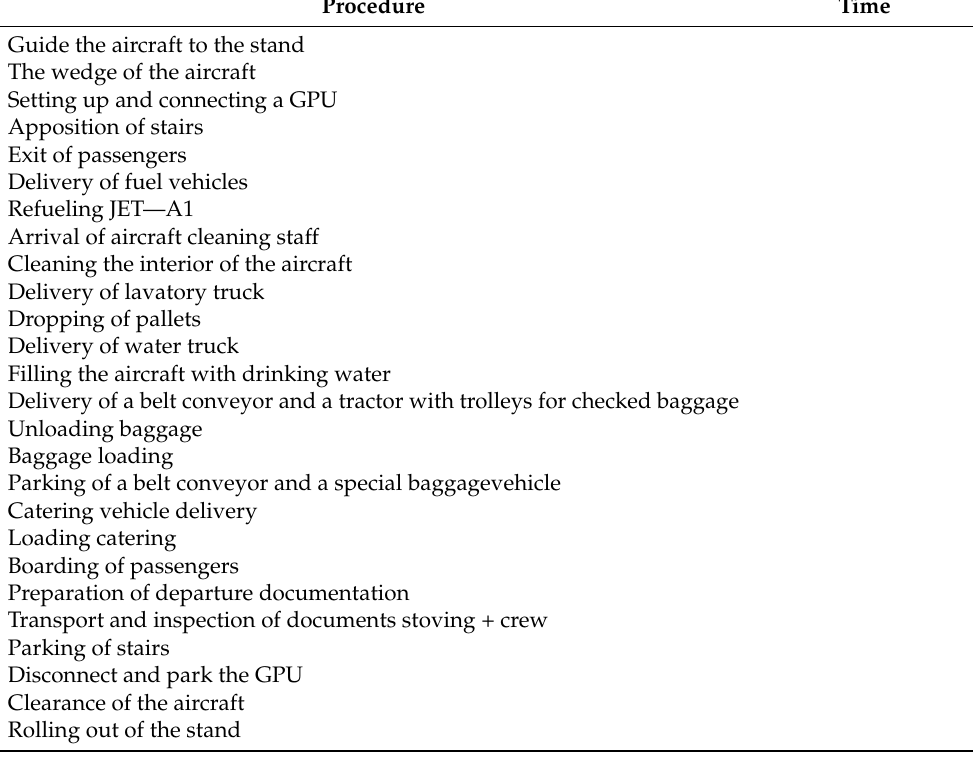
Table 1. Aircraft ground handling